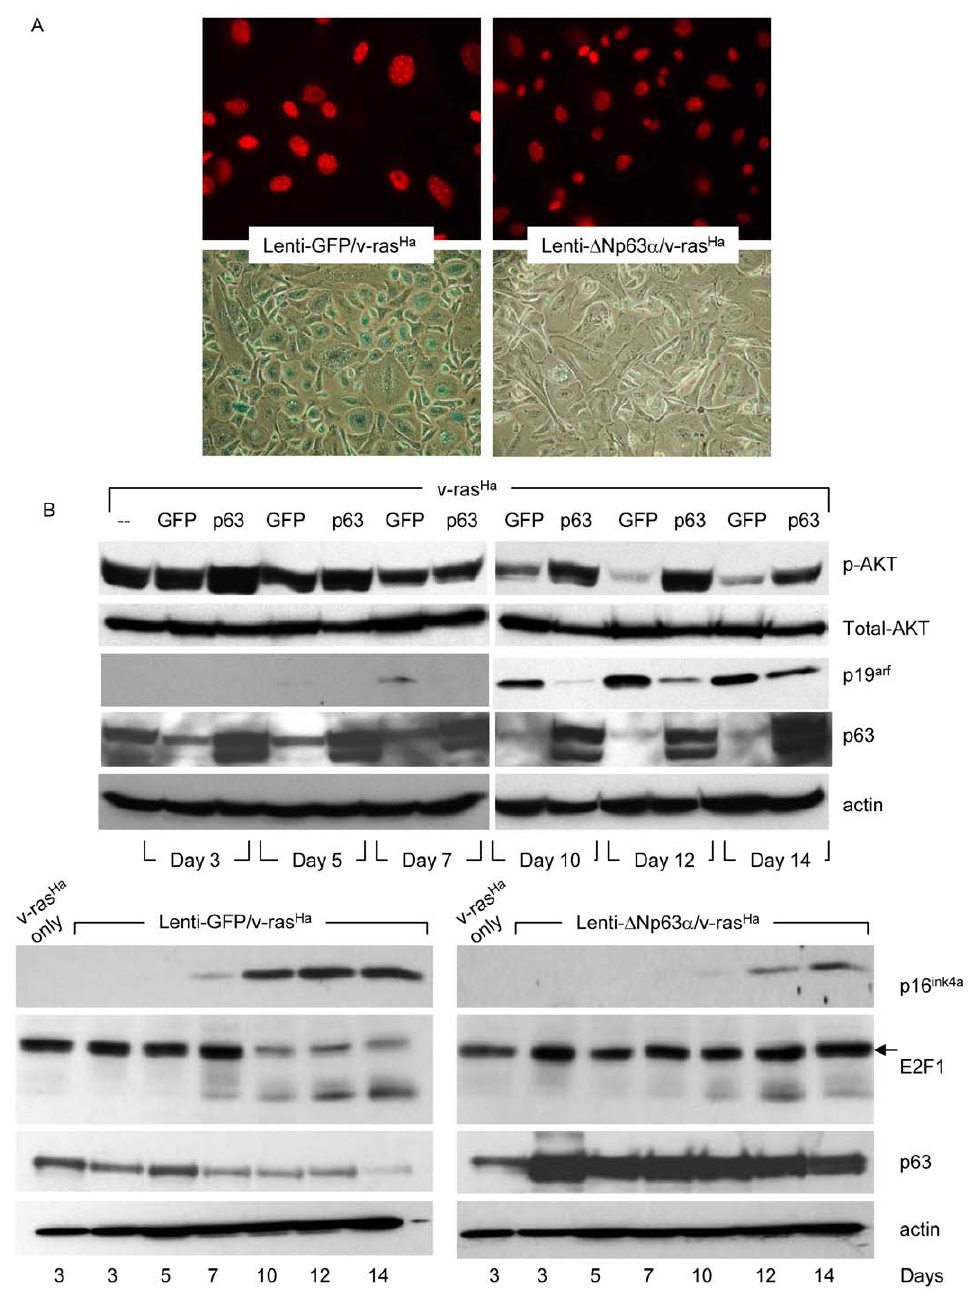
Figure 5. Long term D Np63 a overexpression blocks oncogene-induced senescence. A, Primary keratinocytes were infected sequentially with retrovirus encoding oncogenic v-ras Ha , followed by lentivirus encoding GFP or D Np63 a . Oncogene-induced senescence was assessed 14 days post-lentivirus infection by immunofluorescent analysis of nuclear foci of HP-1 c (upper panel), or enzymatic activity of SA- b -gal (lower panel). The images shown are representative of three independent experiments. B, Whole cell protein was collected from keratinocytes infected sequentially with retrovirus encoding oncogenic v-ras Ha followed by lentivirus encoding GFP or D Np63 a at timepoints indicated following lentiviral gene transduction. The levels of phosphorylated AKT, total AKT, p19 arf and p63 were detected by western blot (upper panels). p16 ink4a and E2F1 levels with corresponding p63 expression are presented in the lower panels. Equal protein loading was confirmed by immunoblotting for b -actin.